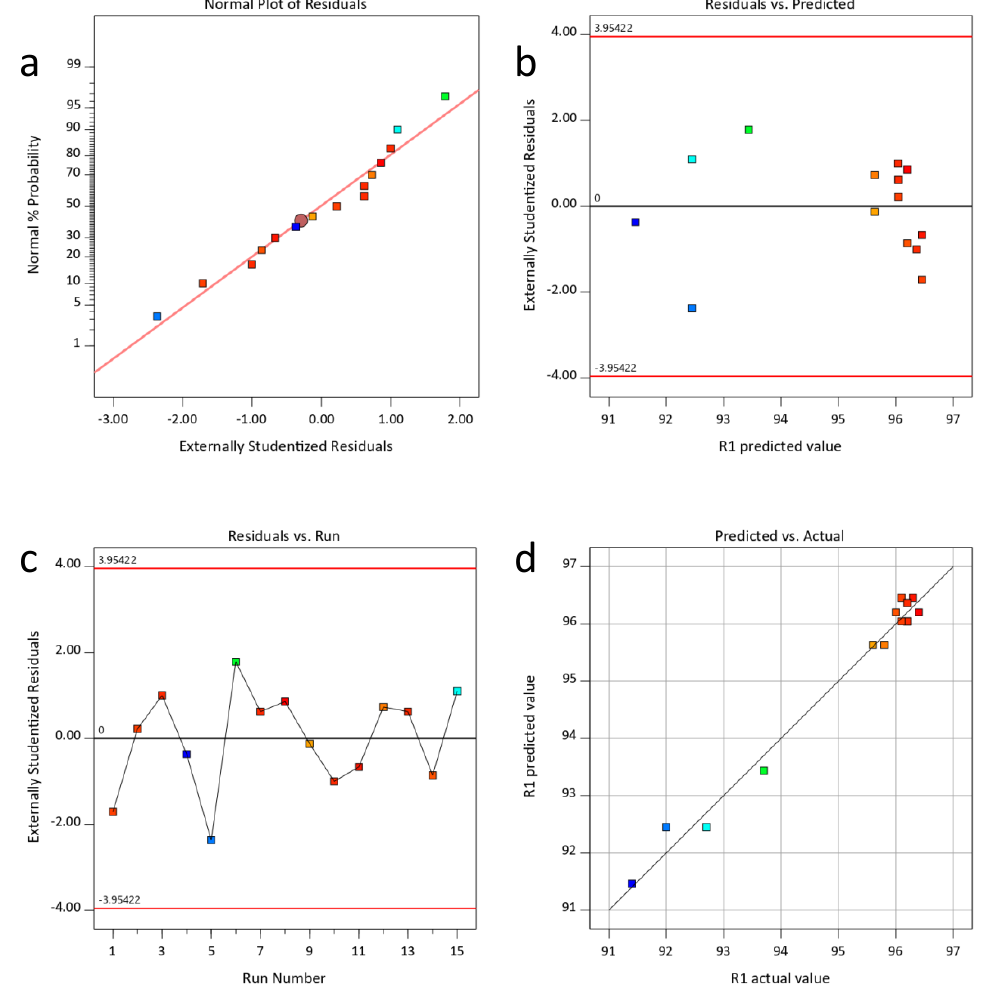
Figure 2. Model diagnostics for response variable R 1 ( a ) A normal probability plot of the residuals; ( b ) Residuals versus predicted value of R 1 ; ( c ) Residuals versus run number; ( d ) Predicted versus actual value of response variable R 1 . Points on graphs correspond to results of particular experiments and colour points correspond to the value in accordance with the scale.